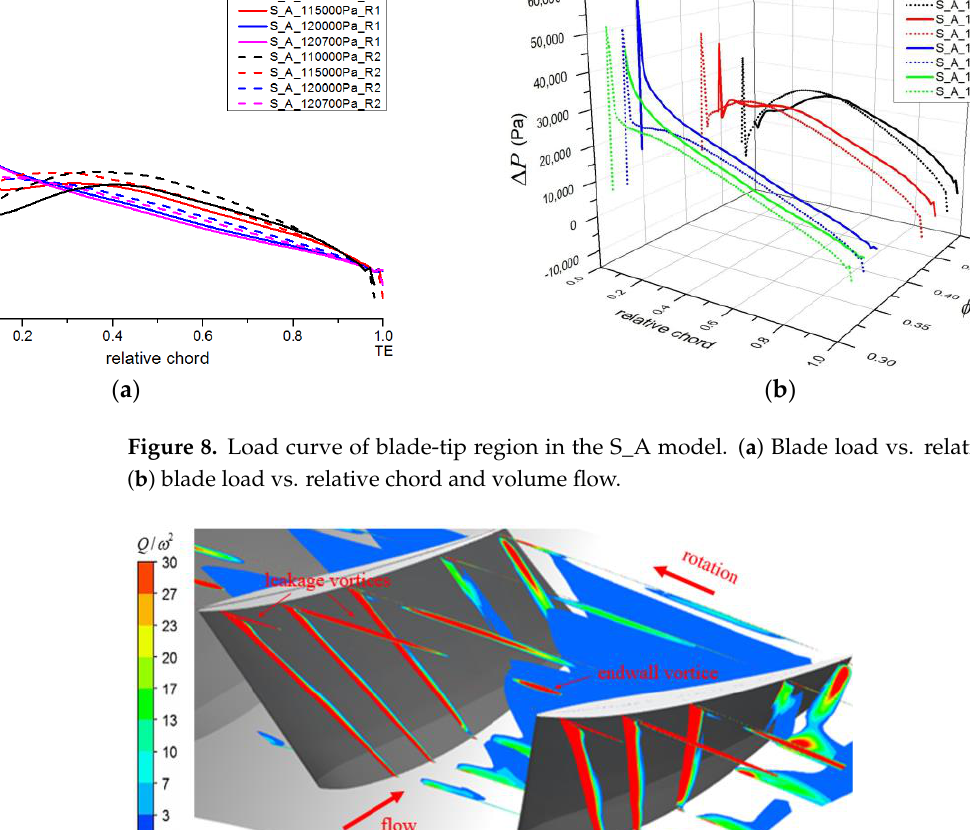
Figure 9. Relative Q-criterion contour of S_A_120700Pa_R1.